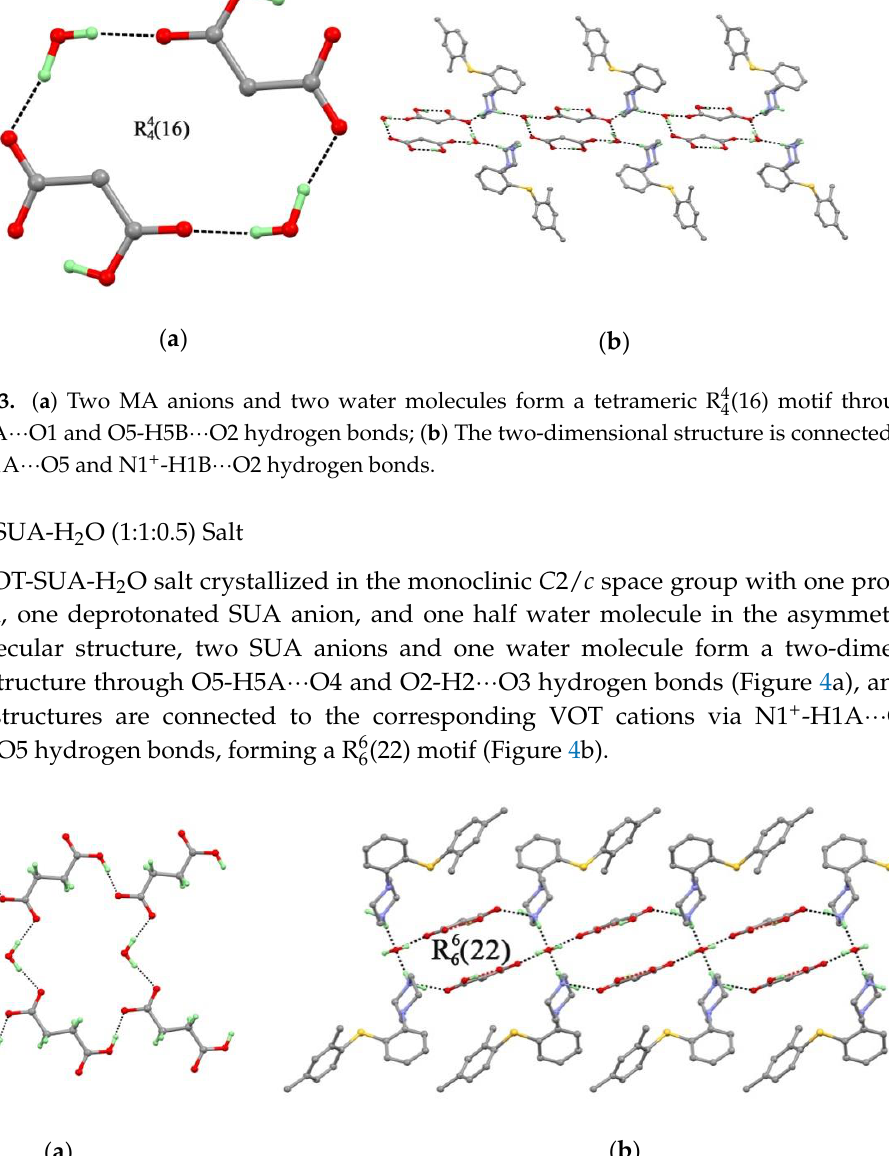
(22) motif structure are connected by 6